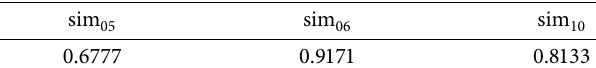
Table 4: Similarity between the proposed project and each case.